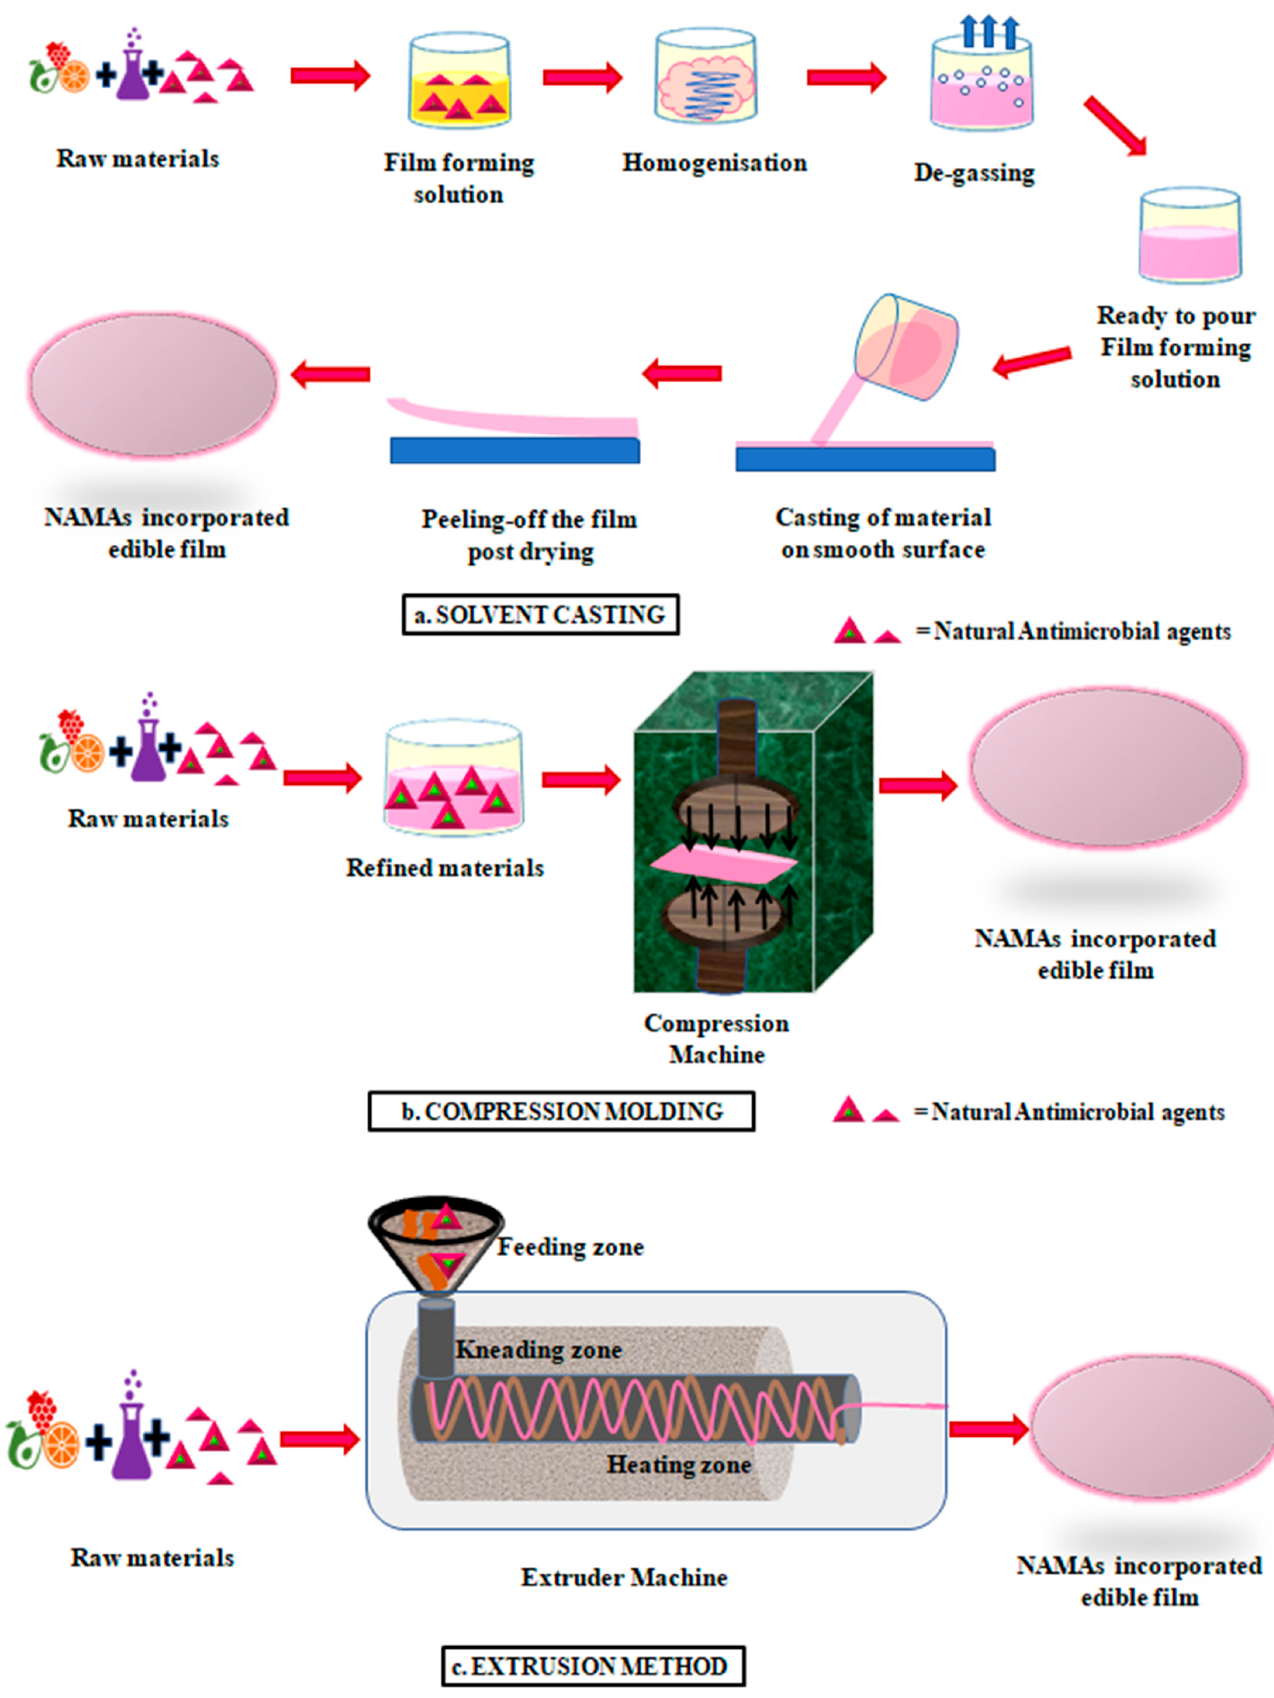
Figure 2. Various methods of film formation ( a ) solvent casting ( b ) compression moulding ( c ) extrusion